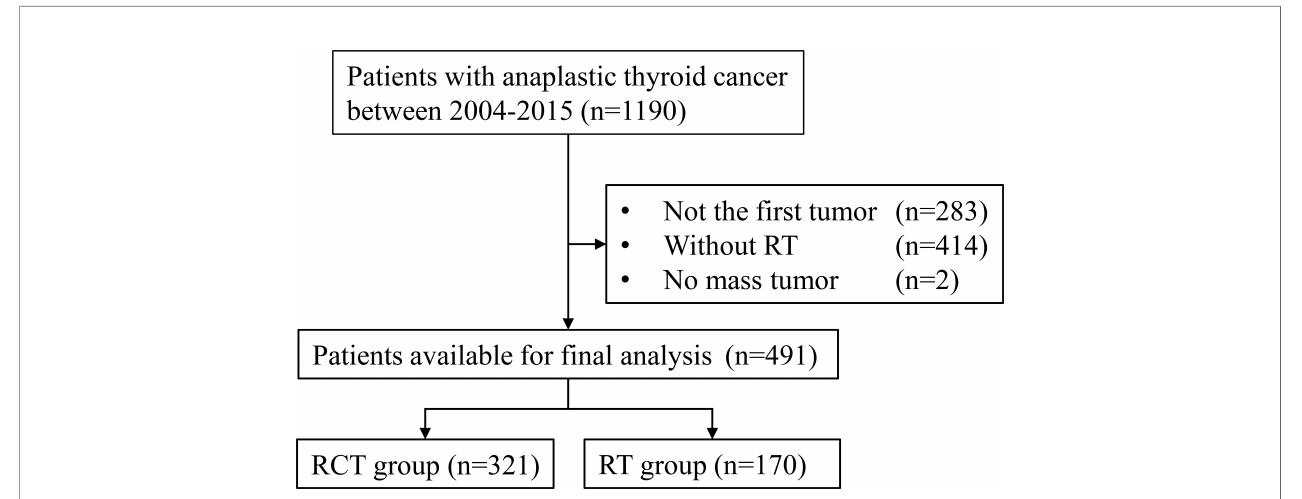
FIGURE 1 | Flowchart of the patient selection procedure. RCT, radiotherapy plus chemotherapy; RT, radiotherapy